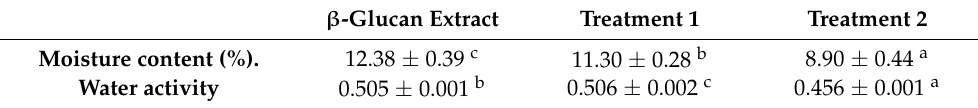
Table 1. Determination of moisture content and water activity.